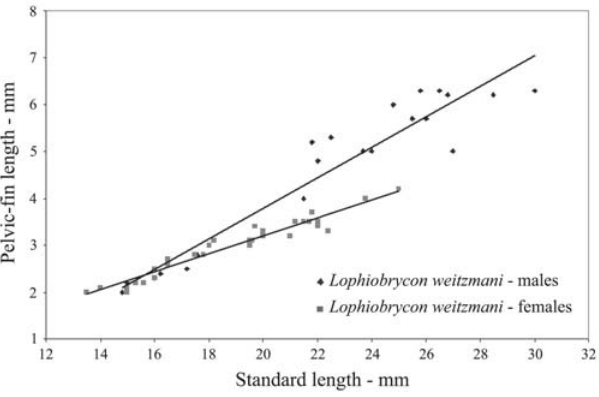
Fig. 10. Lophiobrycon weitzmani . Pelvic-fin length as function of standard length for males